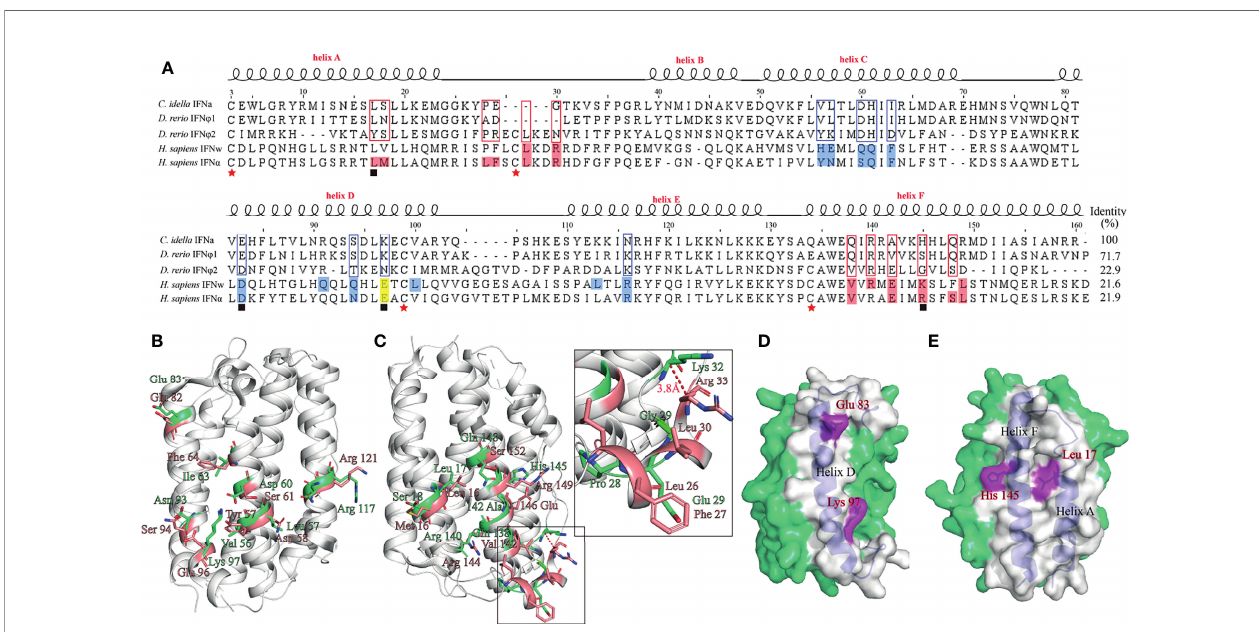
FIGURE 5 | Prediction of key residues of Ci IFNa in the interaction with receptors. The corresponding residues for the interaction of IFNs with IFNAR1 and IFNAR2 in Ci IFNa. (A) Sequence alignment of Ci IFNa with zebra fi sh and human IFNs. Residues for the interaction of human IFNw and IFN a 2 with IFNAR1 are colored marine, and those with IFNAR2 are colored salmon, and the corresponding residues in fi sh IFNs are boxed. Cysteines are indicated by stars. The residues used for mutation are indicated by solid boxes below the alignment. (B, C) Prediction of residues for receptor interaction in the Ci IFNa. Sticks colored in lime green and salmon represent the residues in the Ci IFNa and human IFN- a 2, respectively. (D, E) The positions of selected residues for